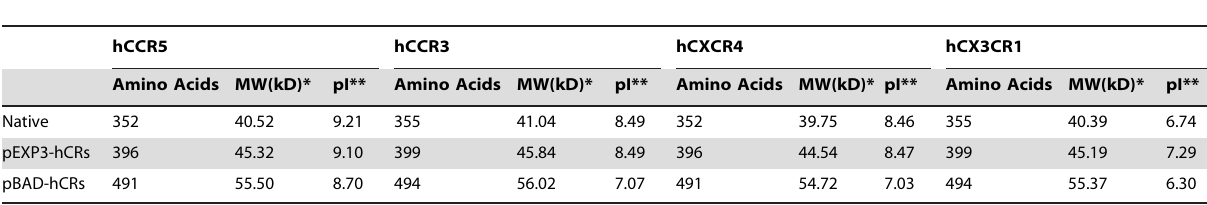
Table 1. Parameters of native and reconstructed human chemokine